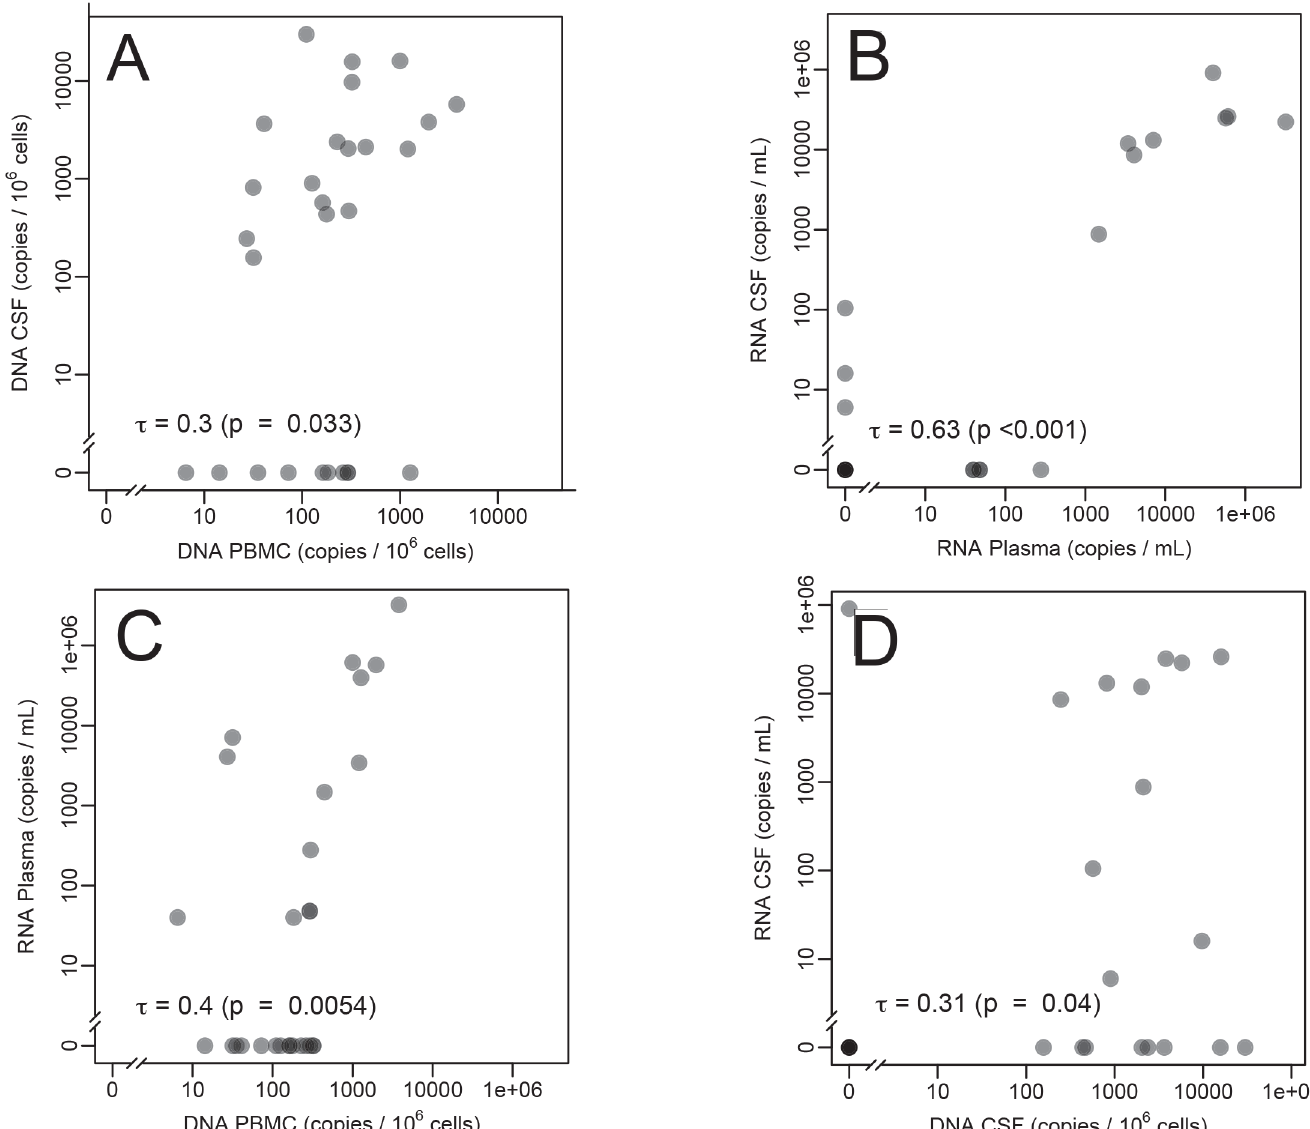
Fig 2. Levels of HIV DNA and HIV RNA within and between blood and CSF. (A) Association of HIV DNA levels between PBMC and CSF. (B) Association between HIV RNA levels between blood plasma and CSF. (C) Association of between HIV RNA in blood plasma and HIV DNA levels in PBMC. (D) Association of between HIV RNA and HIV DNA levels in CSF. Kendall ’ s rank correlation is